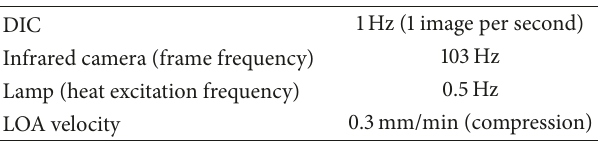
Table 3: Test parameters.